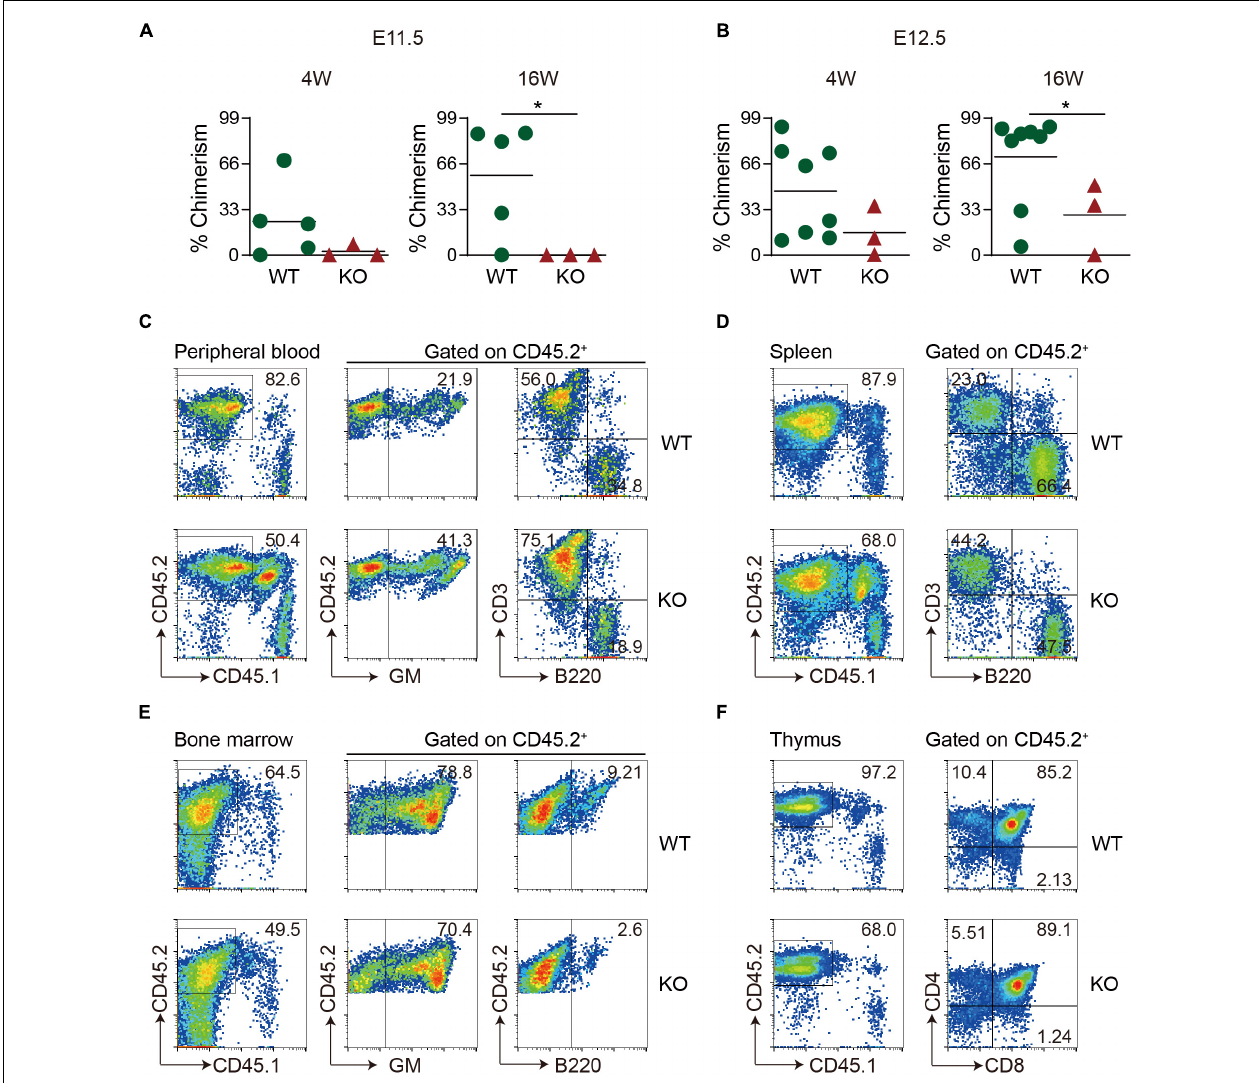
FIGURE 2 | Hematopoietic stem cell activity is decreased in Wip1 knockout head of the E11.5–E12.5 embryo. (A,B) Direct transplantation assay showing the repopulating ability of E11.5 and E12.5 wild-type (WT) and Wip1 − / − embryonic head. Symbols represent the donor chimerism of CD45.2 + cells in peripheral blood of individual recipients in 4 weeks (left) and 16 weeks (right) posttransplantation. * p < 0.05. (C–F) Representative analysis of multilineage output of repopulated recipients receiving E12.5 head cells. The donor contribution is revealed by the presence of the donor of CD45.2 + cells in the myeloid (Gr-1/Mac1), B lymphoid (B220), and T lymphoid (CD3, CD4, and CD8) cells of the peripheral blood (C) , spleen (D) , bone marrow (E) , and thymus (F) in two representative recipients at 6 months posttransplantation. The recipients were injected with 1 embryo equivalent (ee) of E11.5 and E12.5 head